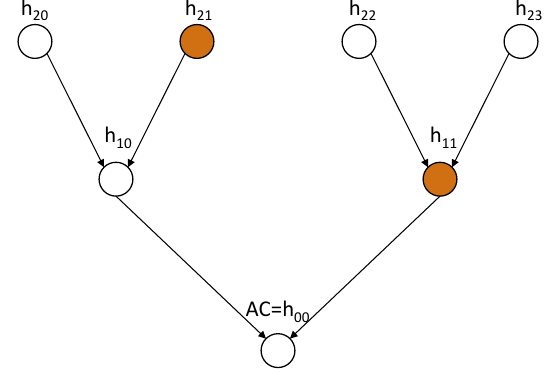
Figure 3. Access policy for SG 1 = { SGD 1 , SGD 2 , SGD 3 , SGD 4 } .